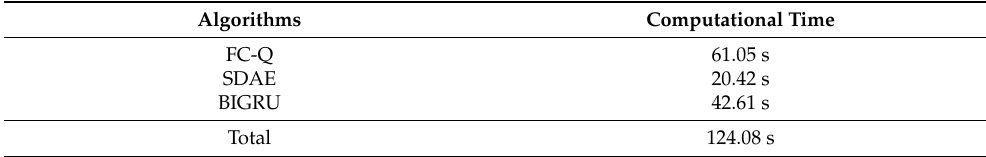
Table 5. The computational time of the proposed